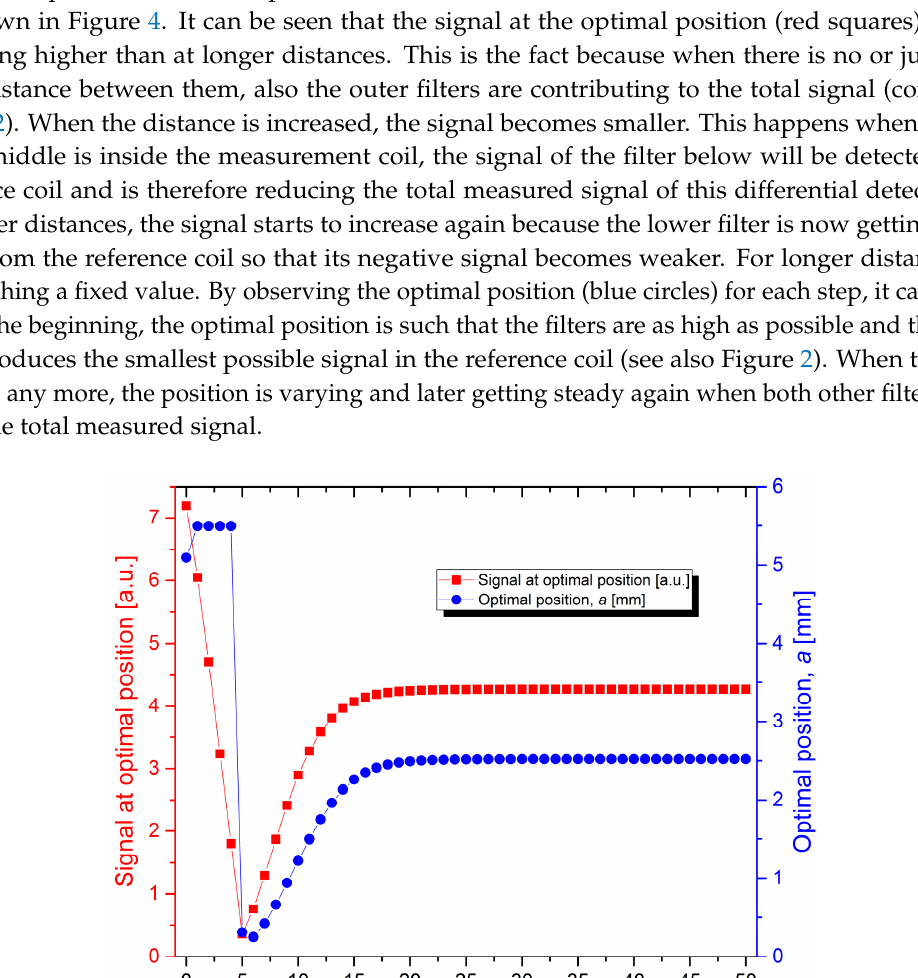
Figure 4. Simulation result for 3 filters (5 × 5 mm) with a grid point-to-point distance of 0.01 mm in the measurement head. Shown is the optimal position a (blue circles) and the value at this optimal position (red squares) as a function of the spacing d between the filters. This distance d is swept in steps of 1 mm from 0 to 50 mm.